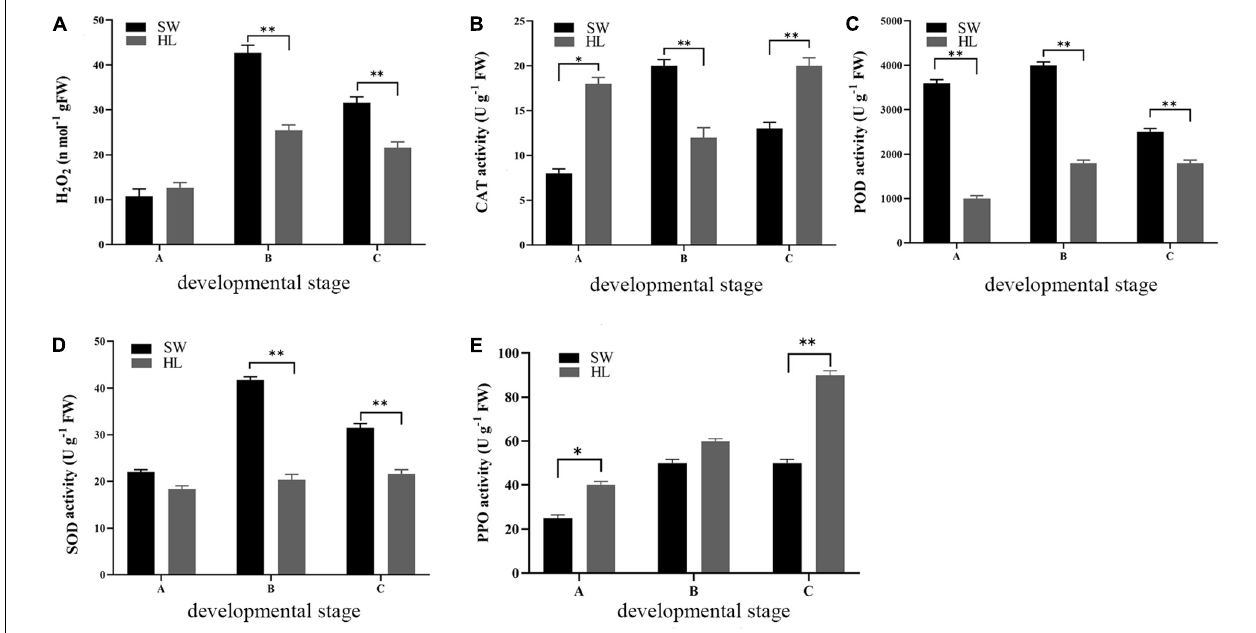
FIGURE 2 | Hydrogen peroxide (H 2 O 2 ) content (E) and antioxidant enzyme activities of “HL” and “SW” buds during infestation by gall wasp Dryocosmus kuriphilus (GWDK) gall wasps [ (A) polyphenol oxidase (PPO); (B) catalase (CAT); (C) peroxidase (POD); and (D) superoxide dismutase (SOD)]. Asterisks indicate a significant difference (* P < 0.05, ** P < 0.01) between ‘HL’ and ‘SW’.